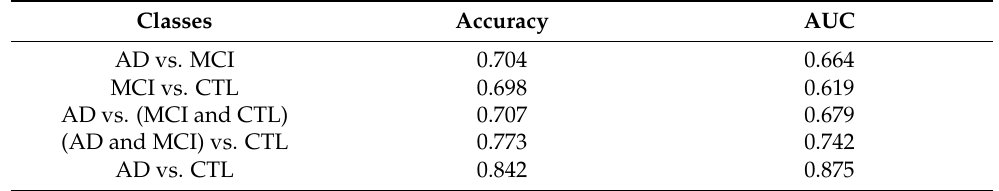
Table 3. Pairwise classification results.